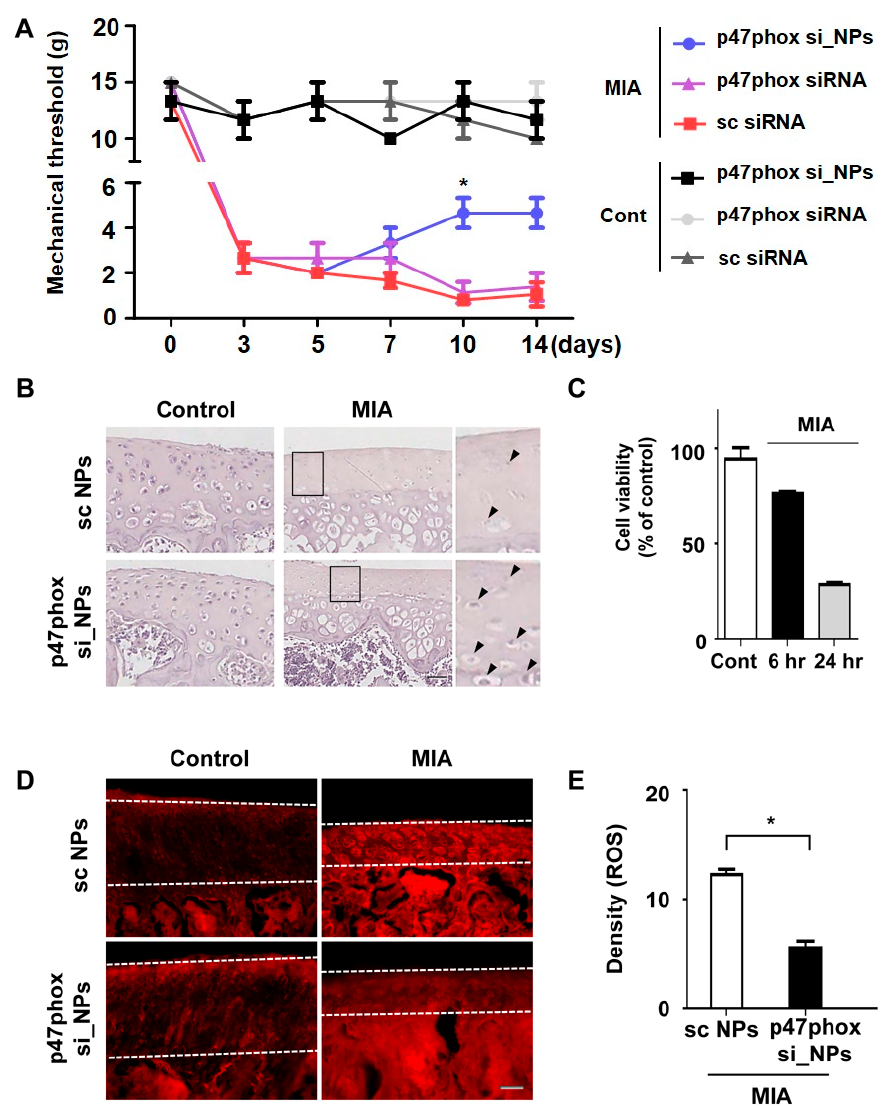
Figure 4. p47phox siRNA-encapsulated PLGA NPs reduced chondrocyte cell death by decreasing ROS production in OA rats. ( A ) On day 3 after MIA-induced OA, p47phox siRNA-loaded NPs were directly administered to the knee via intra-articular injections, and von Frey filament tests were performed on days 7, 10, and 14 after injection; all data are presented as the mean ± standard error of the mean. ( B ) Representative hematoxylin-stained sections of knee joints from rats with MIA-induced OA after 14 days, scale bar = 50 µ m. ( C ) Cell viability over time in human primary chondrocytes following MIA injection. ( D ) DHE fluorescence imaging of knees in the OA rat model at 1 week after injection of PLGA NPs; white lines indicate cartilage in the tissue, scale bar = 50 µ m. ( E ) Density of fluorescence intensity showing ROS production; all data represent the mean ± standard error of the mean (error bars) of three experiments.